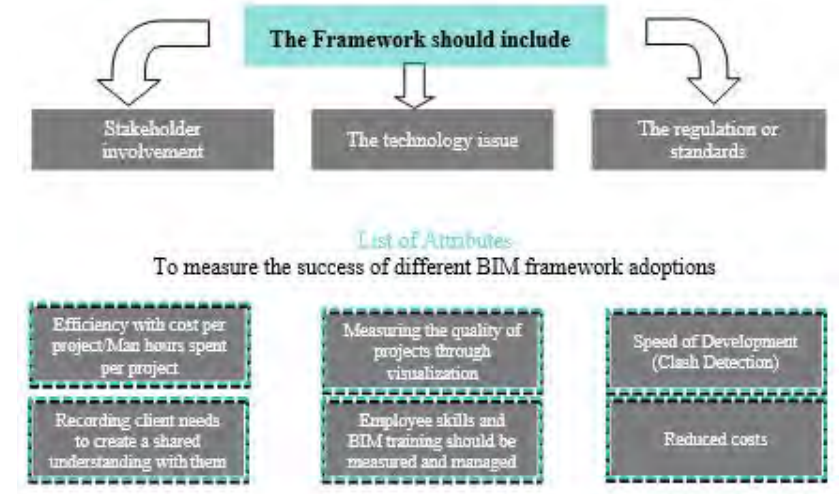
Figure 5. analyses of BIM framework and standards